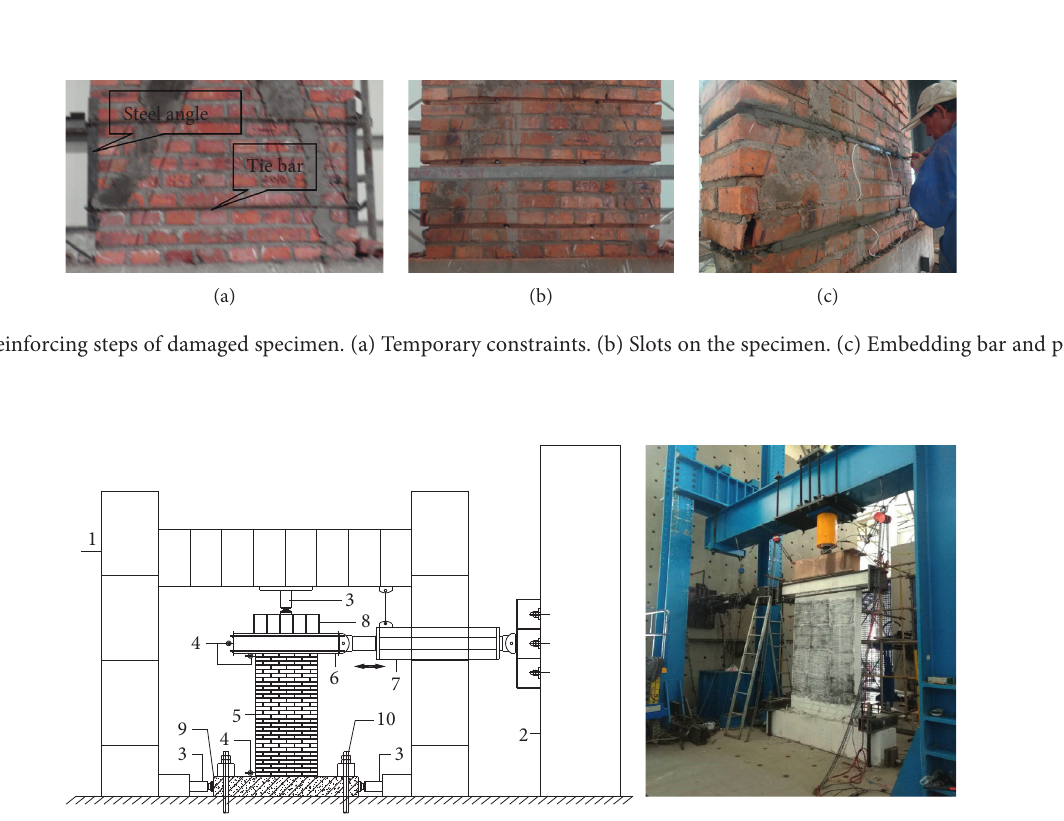
Figure 3: Diagram and real photo of testing devices. 1, reaction force frame; 2, reaction wall; 3, jacking device; 4, displacement meter; 5, specimen; 6, cap beam; 7, actuator; 8, distribution beam; 9, base beam; 10, anchoring